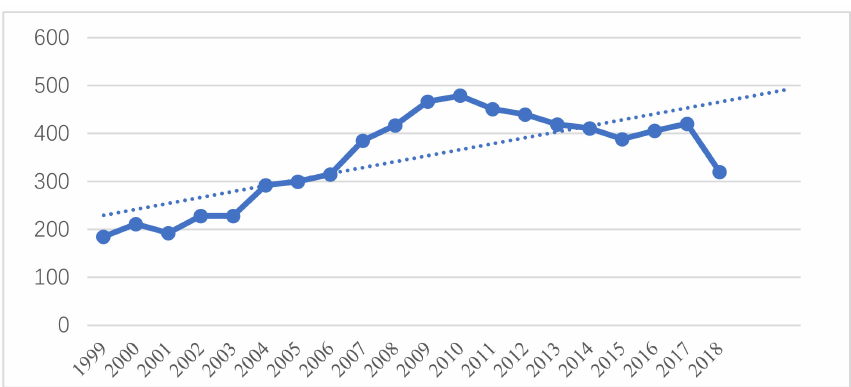
Figure 5. The trend of quantity change of linguistics periodicals in